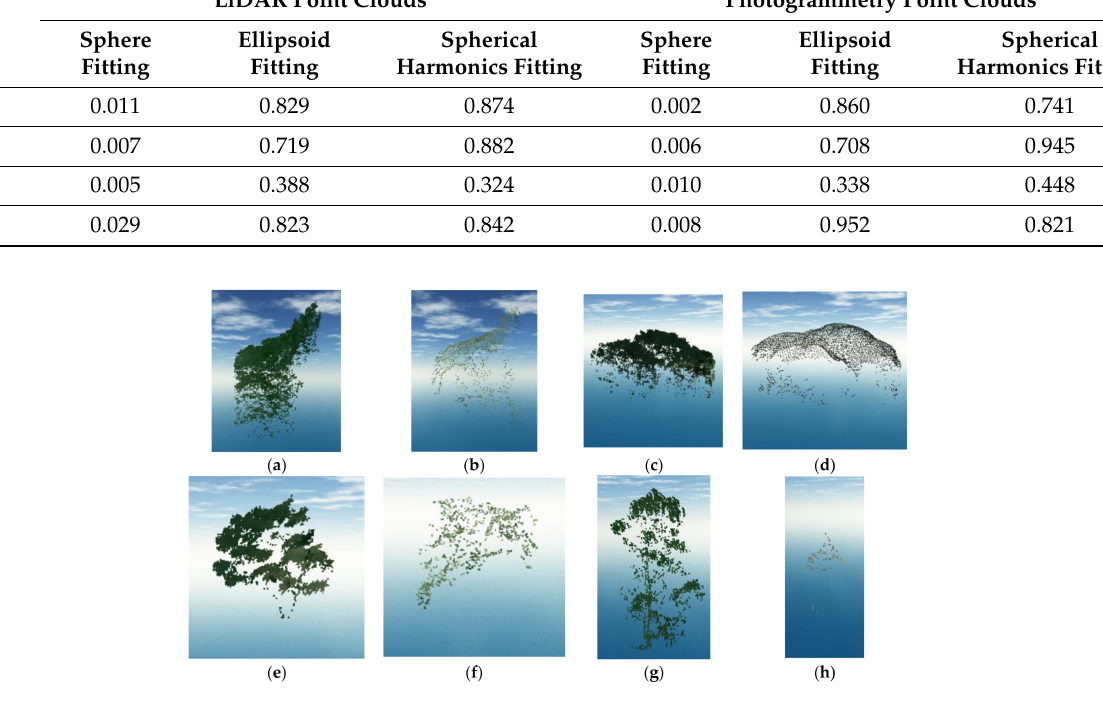
Figure 8. Point clouds from ( a ) the first tree sample using the LiDAR method, ( b ) the first tree sample using the photogrammetric method, ( c ) the second tree sample using the LiDAR method, ( d ) the second tree sample using the photogrammetric method, ( e ) the third tree sample using the LiDAR method, ( f ) the third tree sample using the photogrammetric method, ( g ) the fourth tree sample using the LiDAR method, and ( h ) the fourth tree sample using the photogrammetric method. Table 3 shows the R 2 value from each modeling carried